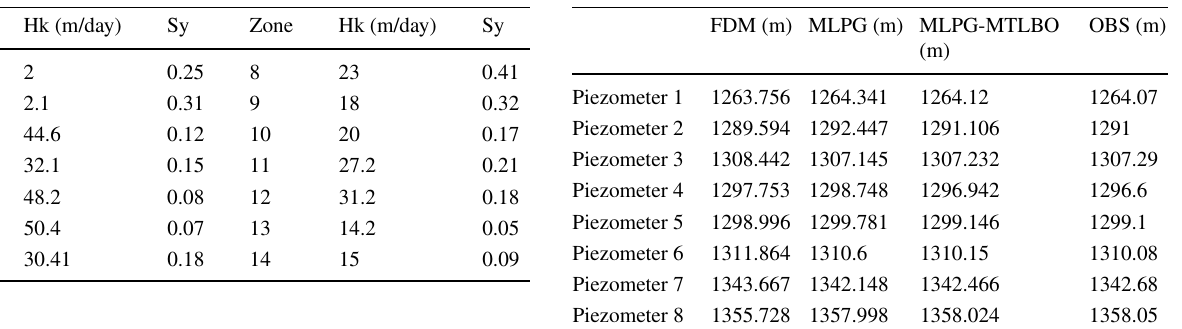
Table 3 Estimated hydrodynamic values for all the zones of aquifer Table 4 Groundwater table at the end of first month of